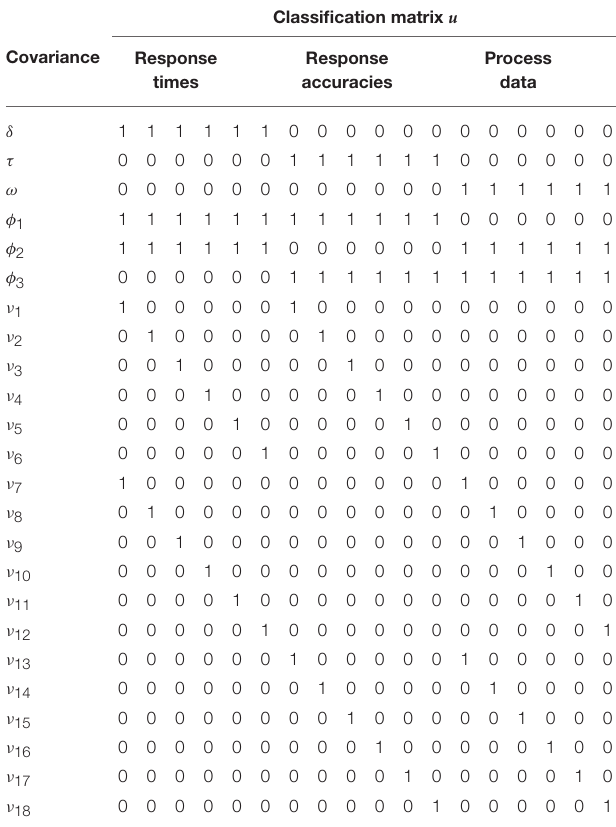
TABLE 5 | The additive covariance structure for a BCSM that incorporates additional process data, next to RTs and